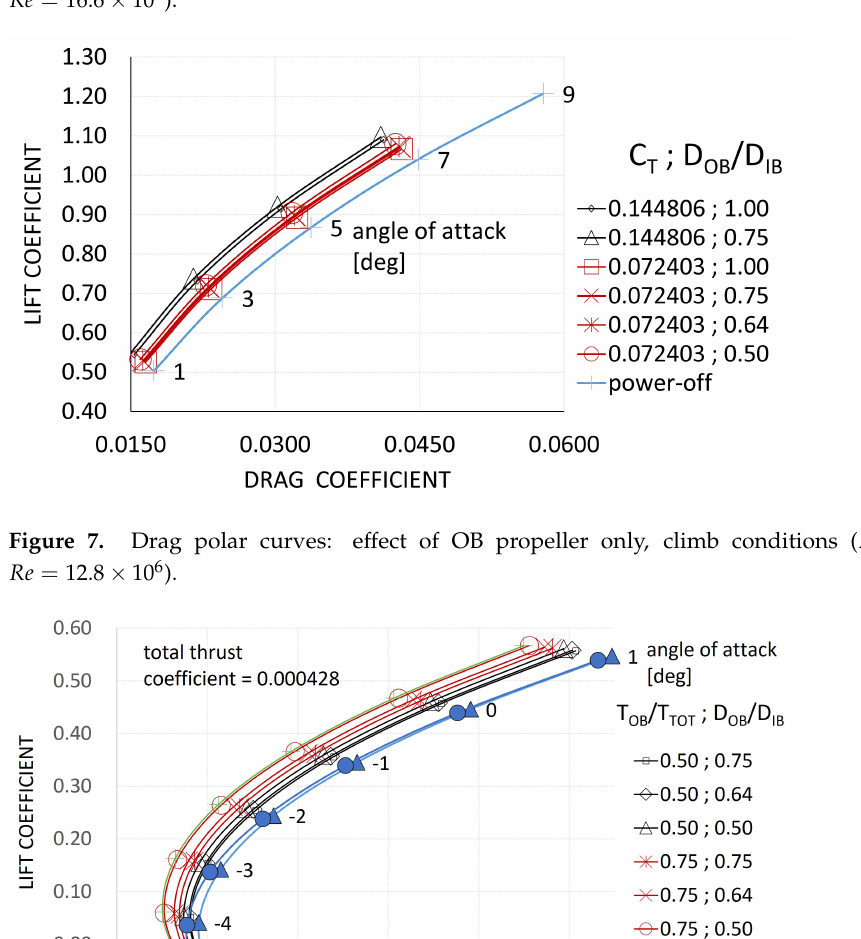
Figure 6. Drag polar curves: effect of OB propeller only, cruise conditions ( M = 0.480; Re = 16.6 × 10 6 ).